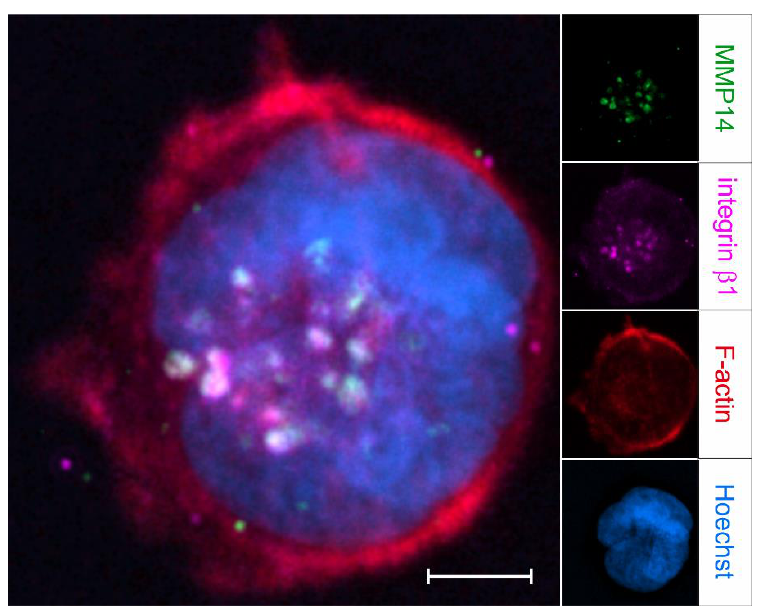
Figure 7. Invadopodia beneath the nucleus of an MDA-MB-231 breast cancer cell in a type I collagen matrix are both proteolytic and adhesive. MMP-14 is immunostained in green, active integrin β1 in magenta, and F-actin in red. The nucleus is counterstained in blue with Hoechst 33,342 dye. Scale bar: 5 µm.